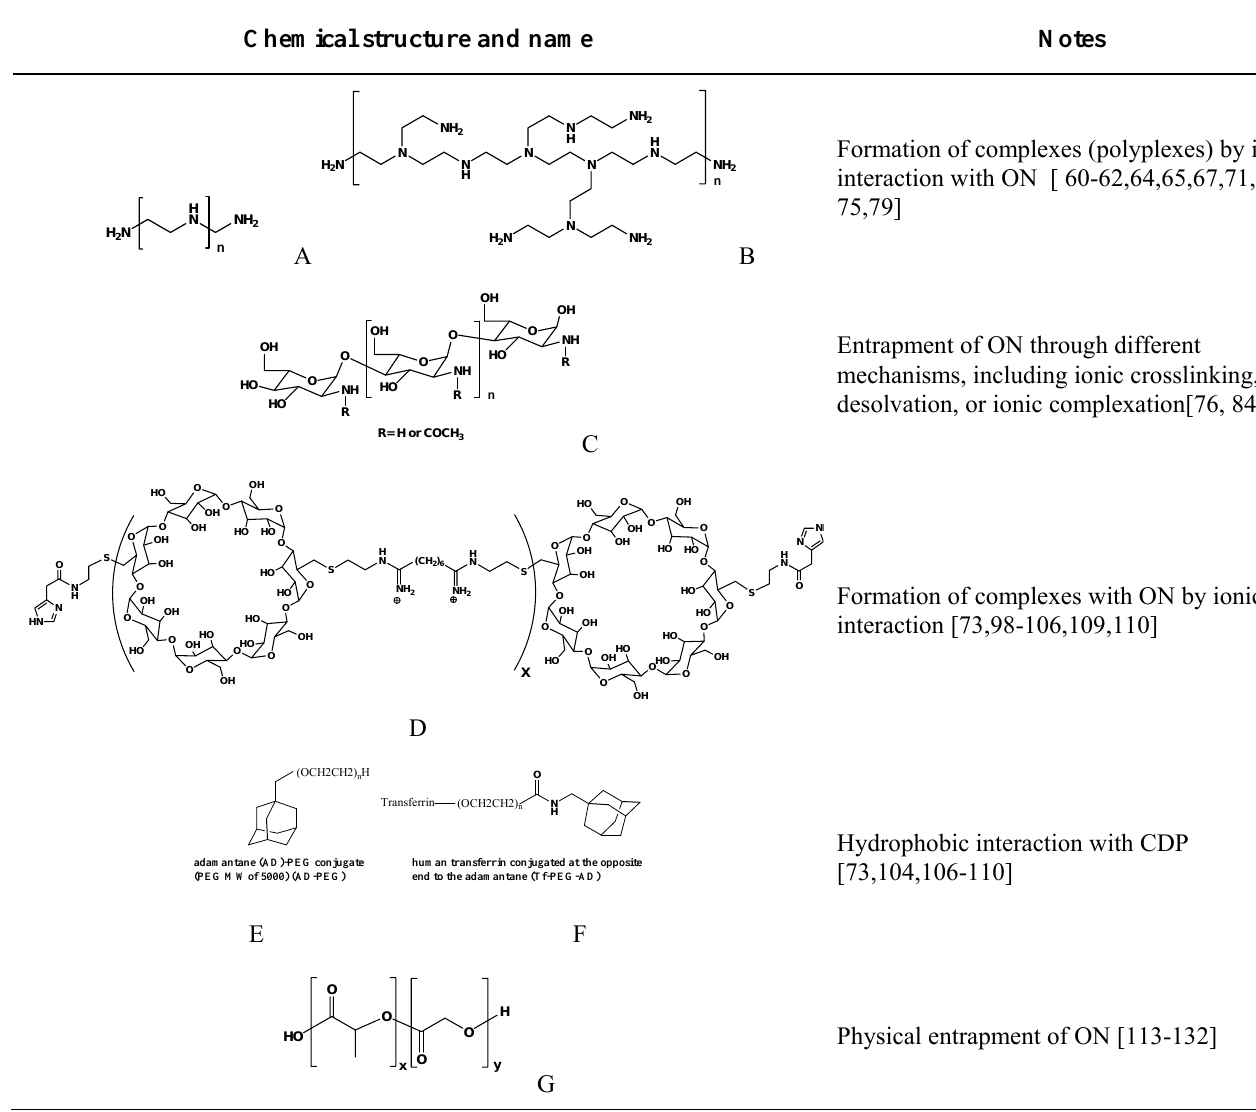
Table 2. Polymers frequently used in the formulation of non-viral vectors for ON